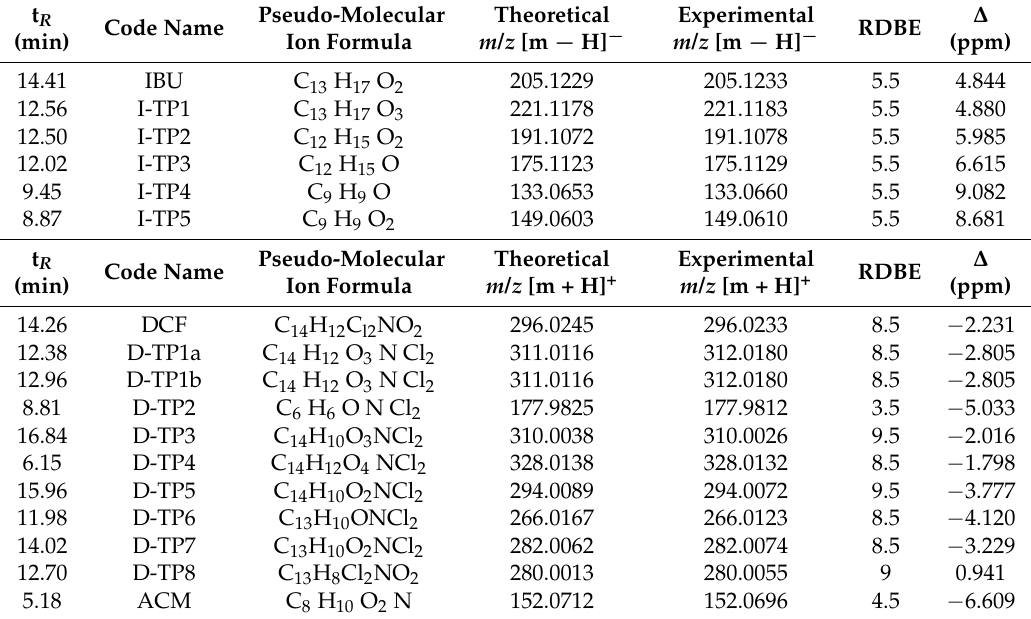
Table 2. High resolution mass spectra data for IBU, DCF, and ACM and their identified TPs derived from mass spectrometric